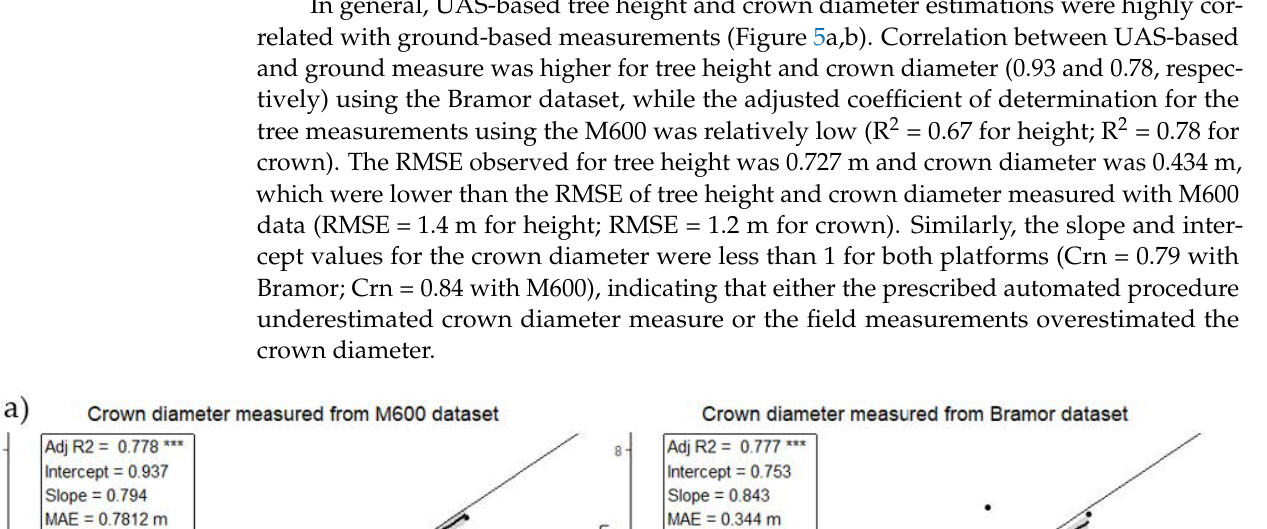
Figure 5. Results of regression analysis between ground-measured and algorithm-derived estimates for the red oak plantation. ( a ) Crown diameter measured using different UAS datasets (M600 and Bramor, respectively). ( b ) Tree height measured using different UAS datasets (DJI Mavic 600 and Bramor, respectively). *** indicates p ≤ 0.001 (statistical significance). Individual tree detection rates show fewer false positives for the walnut plantation compared to the oak plantations (Table 3). This is due to periodic thinning and distinct crown structure exhibited by the 50-year-old walnut plantation. The height of the tallest tree observed for the walnut plantation was 35 m while it was 12 m for the red oak. This significant difference in height helps distinguish mature trees from underlying vegeta- tions and thereby decrease the commission error. When comparing the two UAS platform datasets (Bramor and M600), the CHM generated from the M600 had higher tree detection accuracy (98%) and lower commission (10%) and omission error (3%), even though the sensor had a relatively low resolution. The stability of a multi-rotor platform during flight minimizes wind effect and thus can capture good-quality imagery, making it an ideal platform for forest monitoring (Appendix A). In contrast, a fixed-wing platform is nimble and fast. However, it is prone to be affected by wind, resulting in wind-swayed treetops [20,21,54], which is probably responsible for the lower accuracy observed in ITD com- pared to the multi-rotor-platform-based inventory. It is important to note that the combi- nation of a variable window filter with MCWS results in higher individual tree detection and measurement accuracy than the fixed window filter for both the datasets in both the plantations (Table 3). It is also important to note that when using fixed window filters, identifying the optimal window size has to be achieved through trial-and-error method. The variable window filter used in this study for detecting local maxima can alter future tree measurement practices with its varying window size and h min to accommodate for the fuzzy crown structure of broadleaf trees. User-defined h min filters out the underlying bushes and codominant branches, thereby controlling oversegmentation [35,37]. The web tool developed to automate the workflow is a straightforward three-click open-source application for users to obtain accurate tree positions, effectively reducing